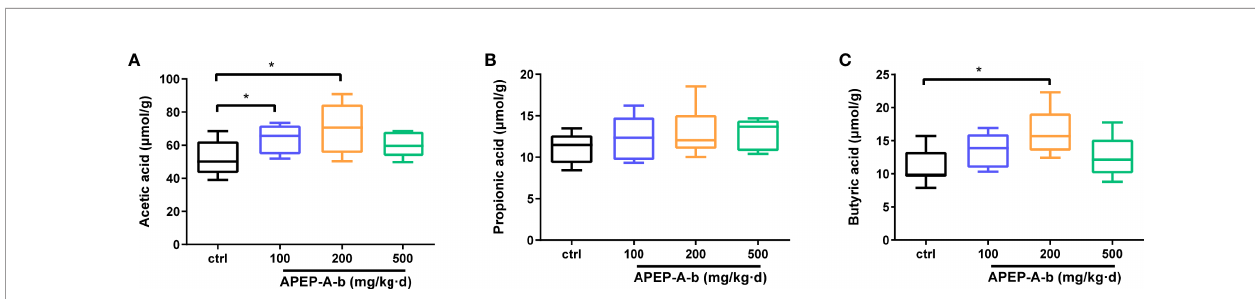
FIGURE 7 | APEP-A-b promotes the production of SCFAs. Effects of the APEP-A-b on the concentration of acetic acid (A) , propionic acid (B) , and butyric acid (C) in cecal contents of mice. Data are represented as the means ± SD (n = 6). * P <